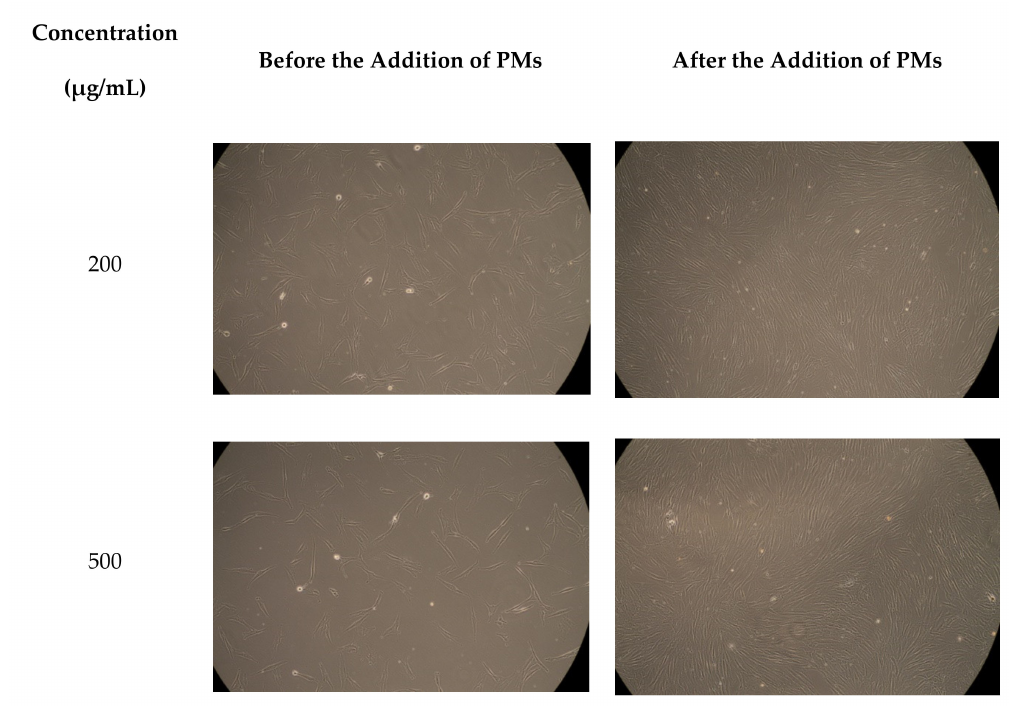
Figure 7. Micrographs of the fibroblast cells before and after the treatment with the